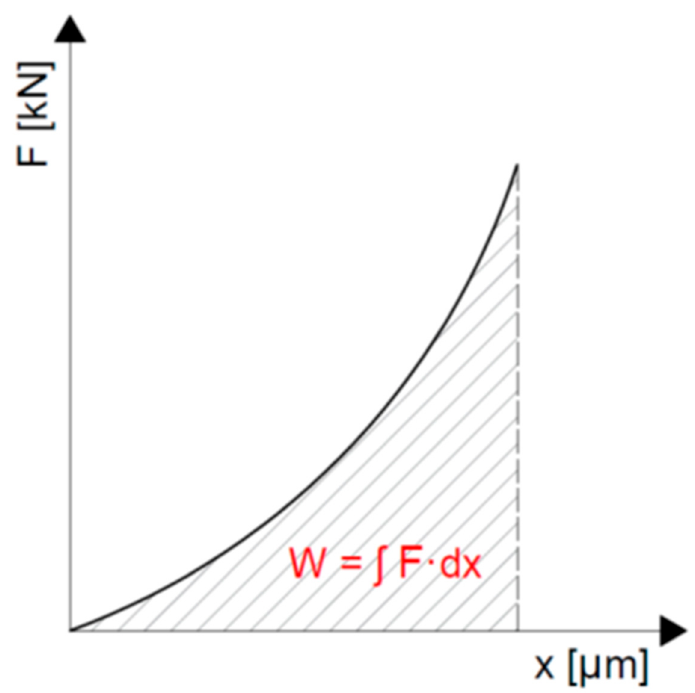
Figure 2. Theoretical graph illustrating determination of the work done by a strength testing machine in a Brazilian test.